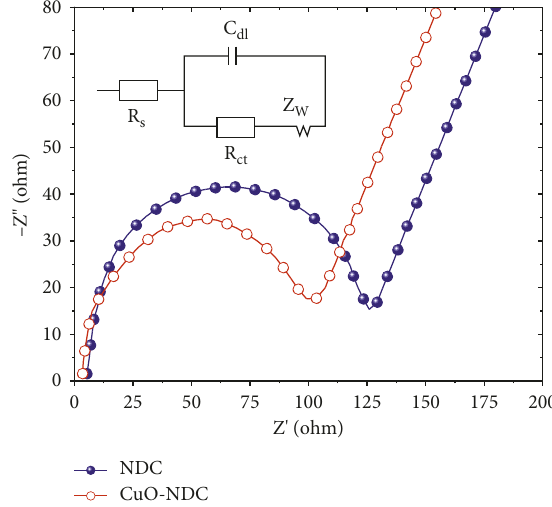
Figure 6: EIS of NDC/GCE and CuO-NDC/GCE in 0.1M KCl electrolyte solution containing equimolar 1mM [Fe(CN)].